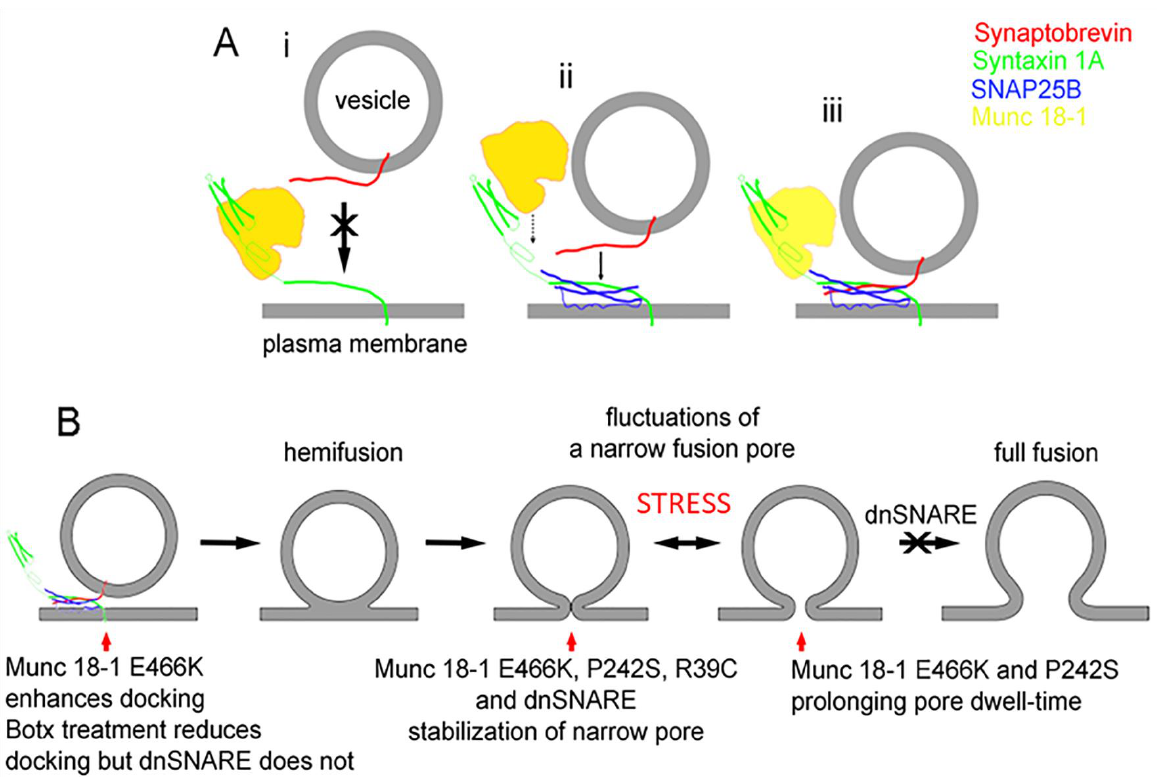
FIGURE 4: A diagram displaying the interaction of Munc18-1 an SNARE proteins along the stages of exocytosis. (A) The interaction be- tween Munc18-1 and SNARE proteins, indicating that Munc18-1 favours the formation of the ternary SNARE complex where synaptobrevin binds preferably with the binary complex between syntaxin and SNAP25. (B) The stages from docking/priming, hemifusion state, leading to fusion pore formation and full fusion, with the action of respective Munc18-1 mutants and dnSNARE peptides. From Ref